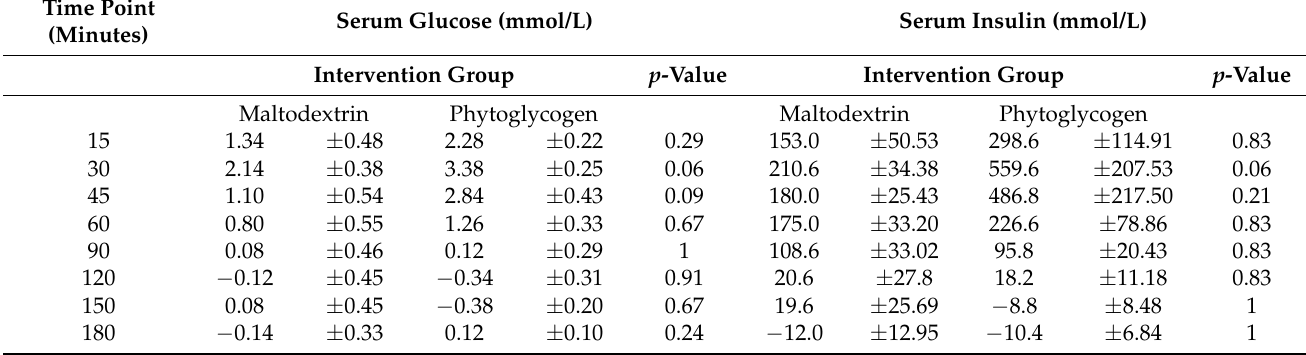
Table 3. Serum Glucose and Serum